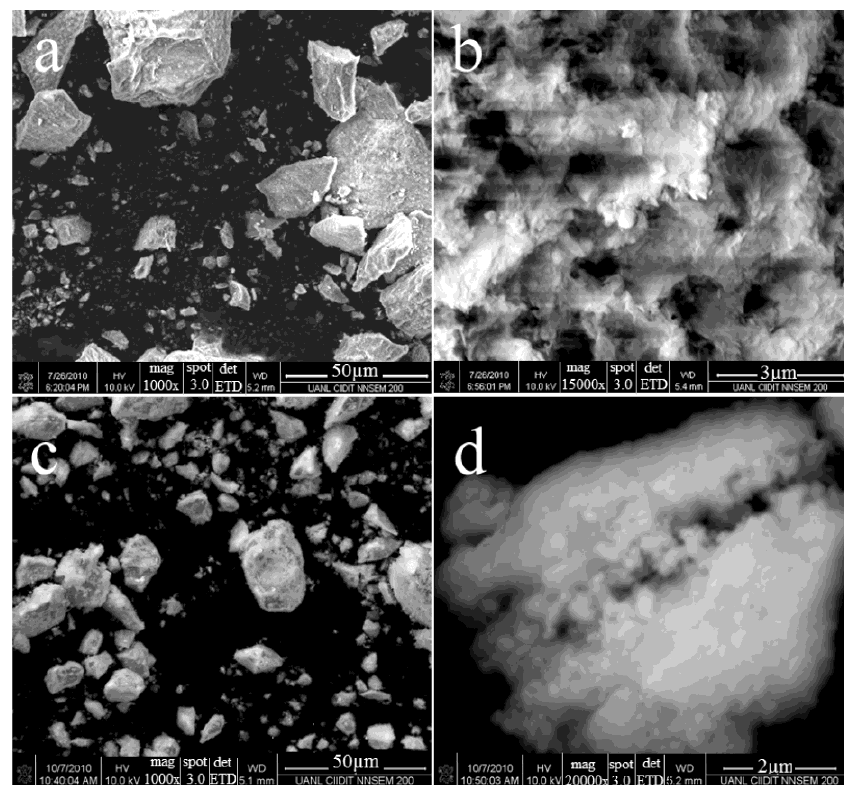
Figure 3. Scanning electronic microscopy (SEM) micrographs using two magnifications of AFSG ( a , b ) and AFI ( c , d